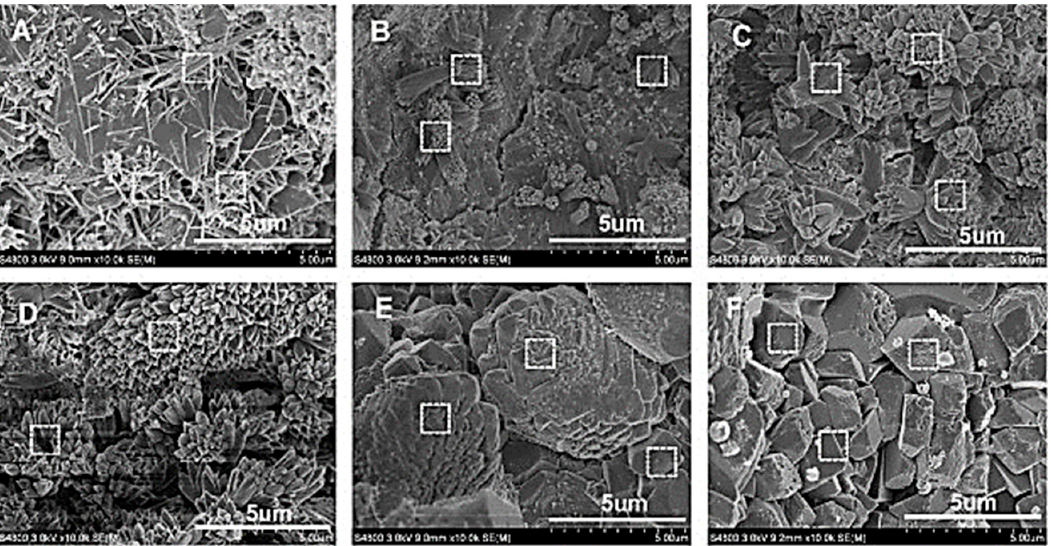
Figure 17. SEM images of cement composite at 28 days mixed with graphene oxide at various percentages: ( A ) no GO; ( B ) GO 0.01%; ( C ) 0.02%; ( D ) 0.03%; ( E ) 0.04%; and ( F ) 0.05%. Reproduced with permission from [115], Elsevier, 2013.